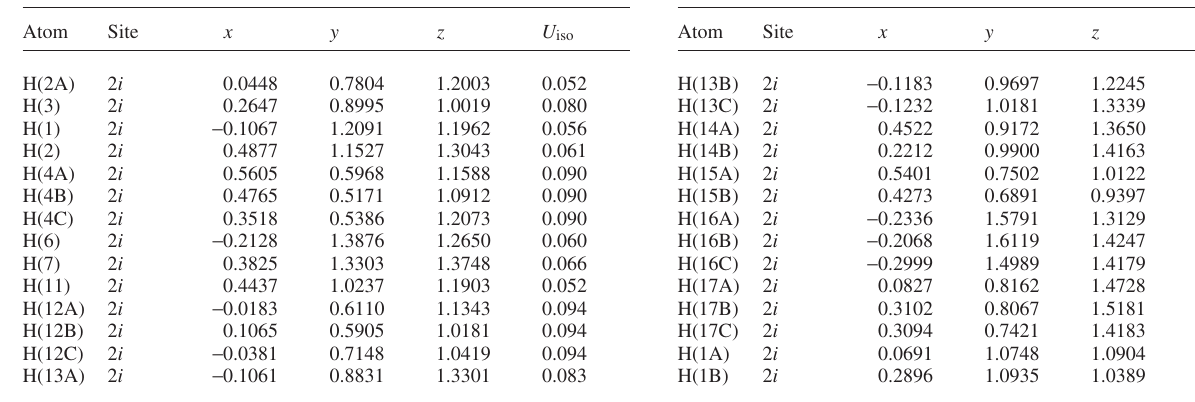
Table 2. Atomic coordinates and displacement parameters (in Å 2 )